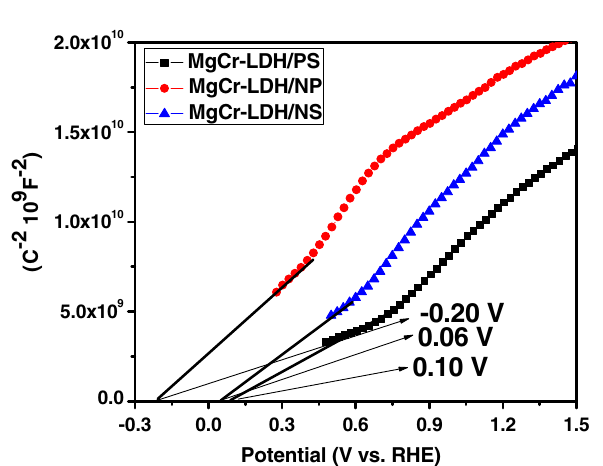
Figure 9. Mott-Schottky plot of MgCr-LDH/PS, MgCr-LDH/NS and MgCr-LDH/NP